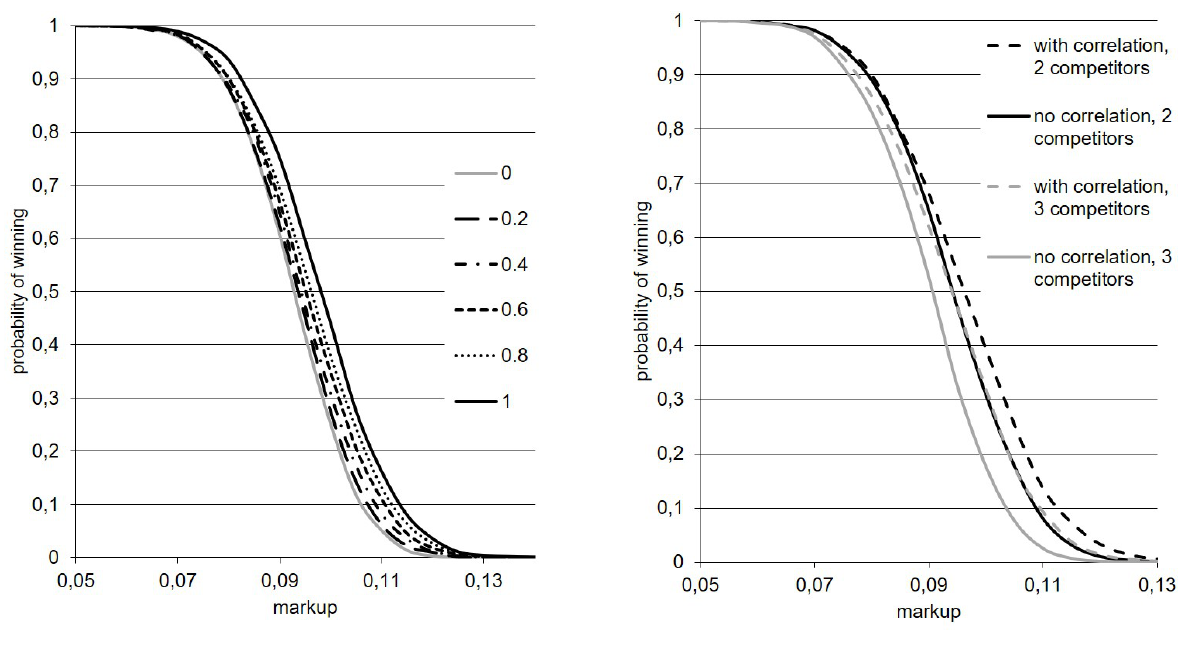
Figure 1: Simulation results: probability of winning against bid markup at different levels of correlation between the competitor’s bids (Pearson correlation coeflcient ρ = { 0, 0.2, 0.4, 0.6, 0.8, 1.0 } )